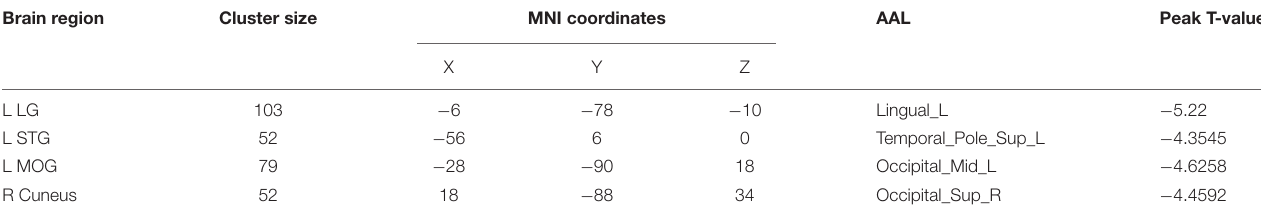
TABLE 3 | ReHo differences between the ASD group and TD group. Brain region Cluster